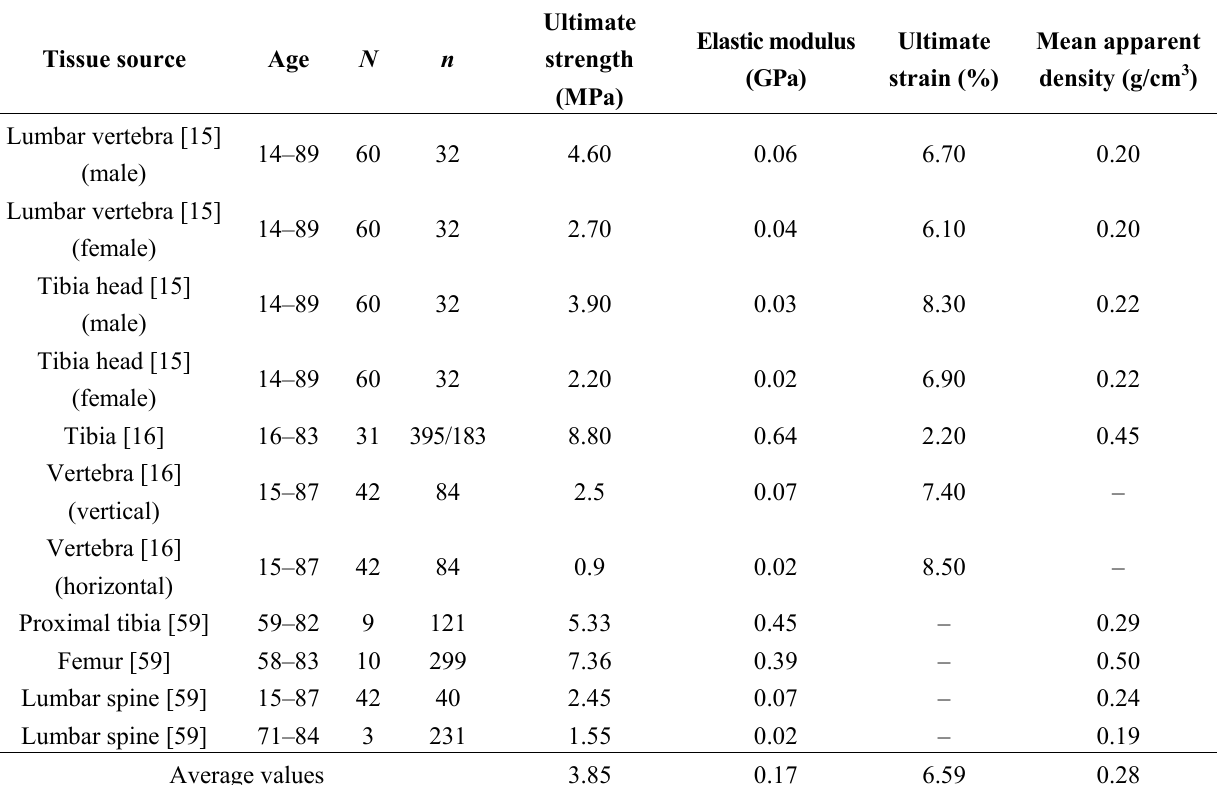
Table 3. Compressive properties of human cancellous bone ( N being the number of bones tested and n , the number of machined samples obtained from them; 395 specimens for elastic modulus, 183 specimens for ultimate strength and ultimate